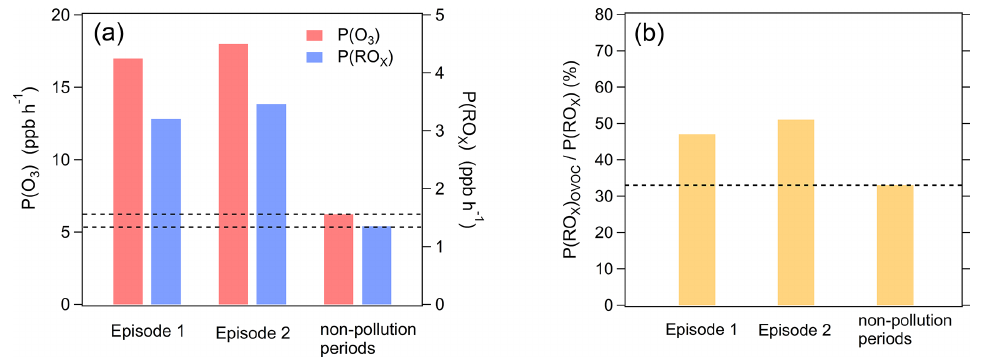
Figure 5. Averaged P (O 3 ), P (RO x ), and the ratio of P (RO x ) contributed by OVOCs to total P (RO x ) ( P (RO x ) OVOC /P (RO x )) during two ozone pollution episodes (episode 1, episode 2) and non-pollution periods. Both P (O 3 ) and P (RO x ) correspond to the scenarios with minimum OVOC contributions to P (RO x